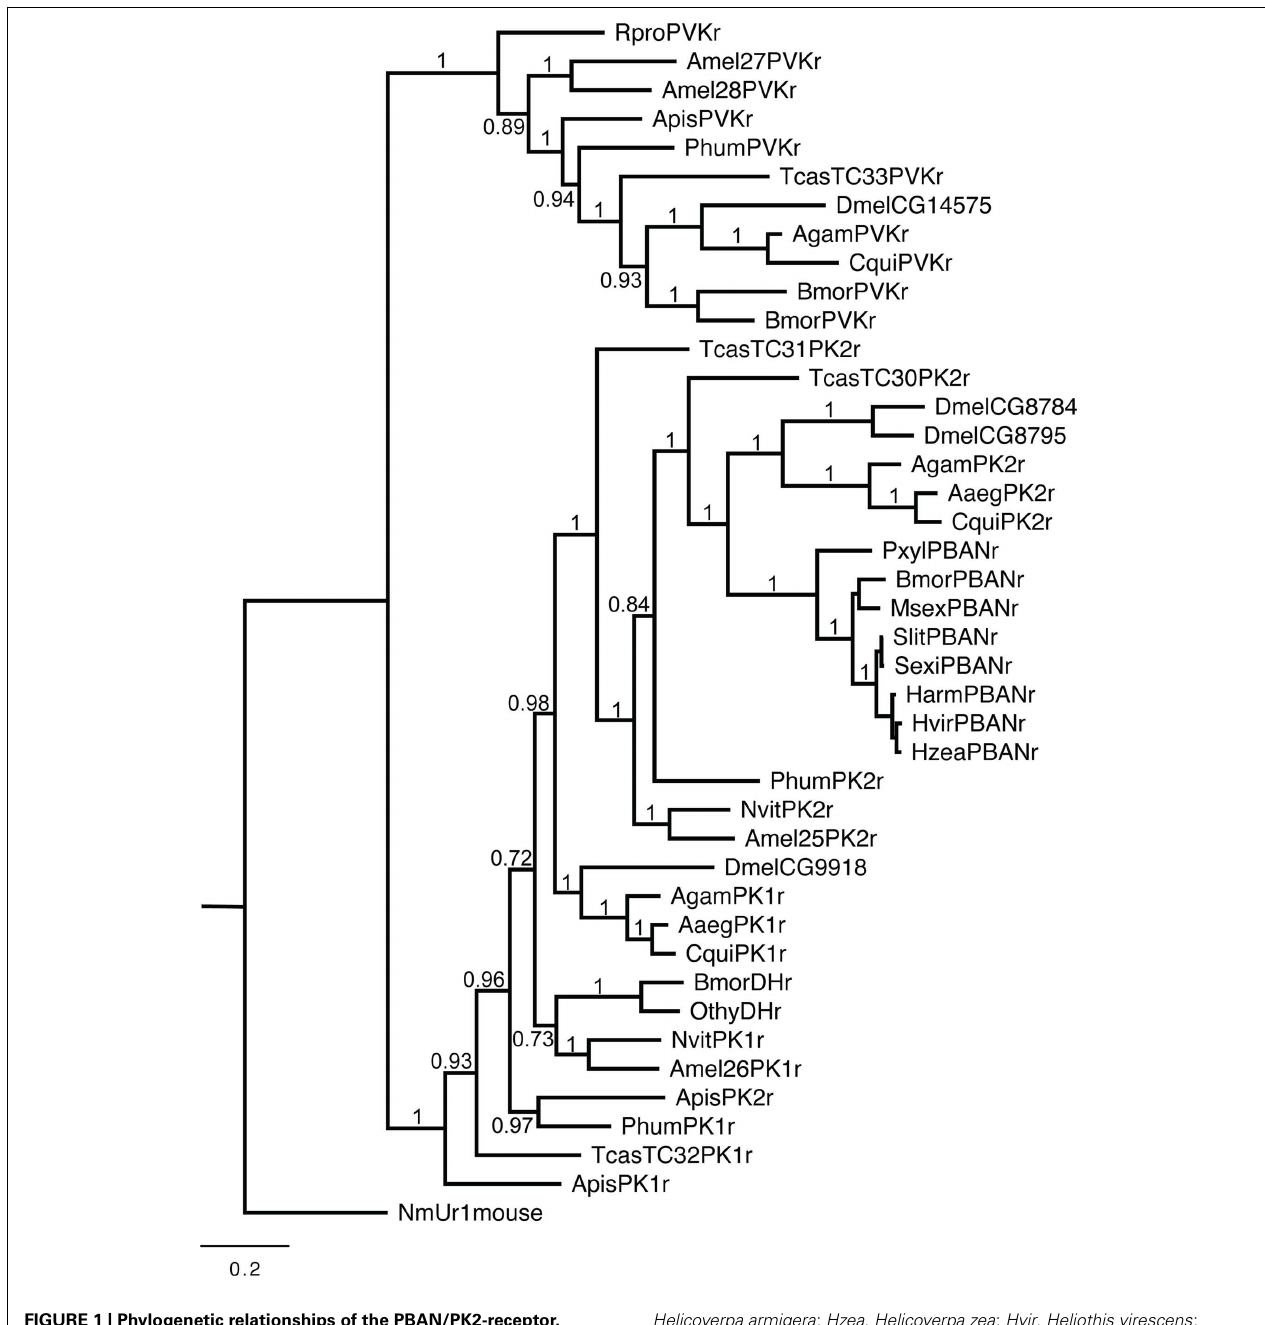
FIGURE 1 | Phylogenetic relationships of the PBAN/PK2-receptor, DH/PK1-receptor, and PVK-receptor. Species abbreviations: Aaeg , Aedes aegypti ; Agam , Anopholes gambiae ; Agos , Aphis gossypii ; Amel , Apis mellifera ; Apis , Acyrthosiphon pisum ; Bmor , Bombyx mori ; Cfor , Coptotermes formosanus ; Cqui , Culex quinquefasciatus ; Dvir , Diabrotica virgifera virgifera ; Dmel , Drosophila melanogaster ; Harm